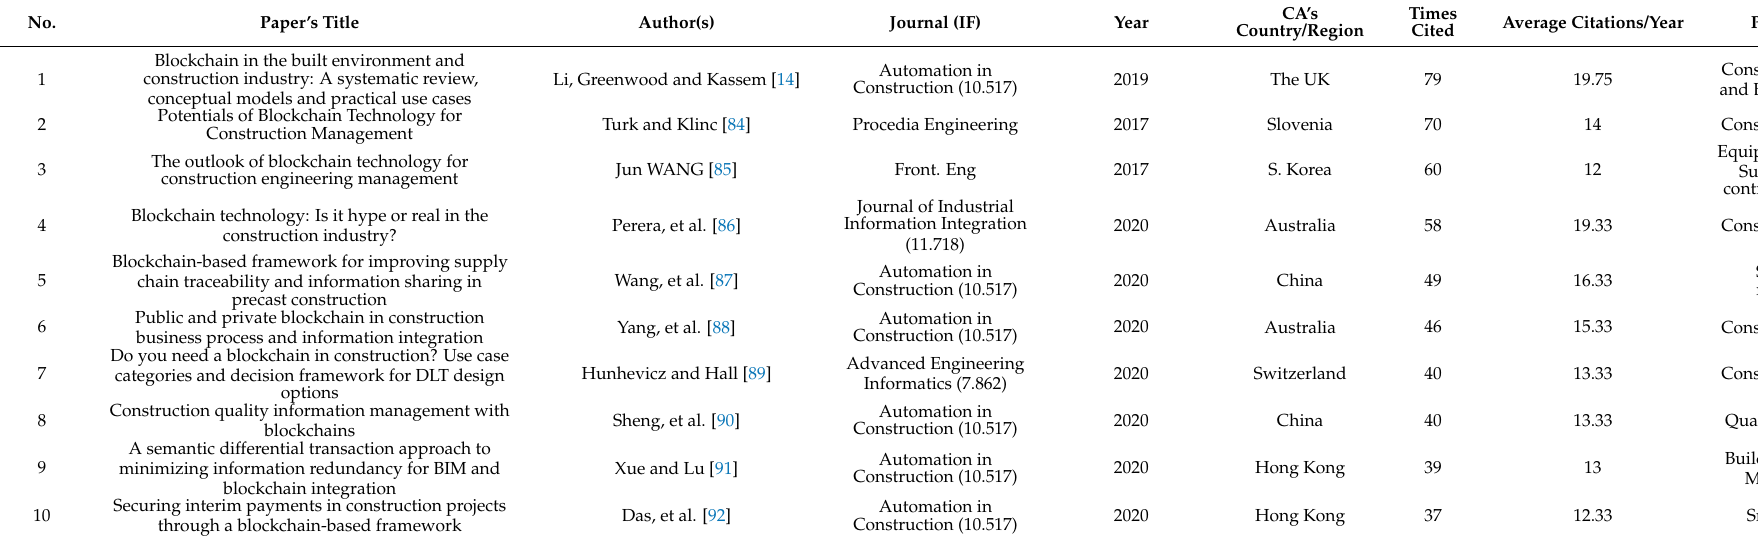
Table 5. Top 10 frequently cited papers in the field of BCT in the construction